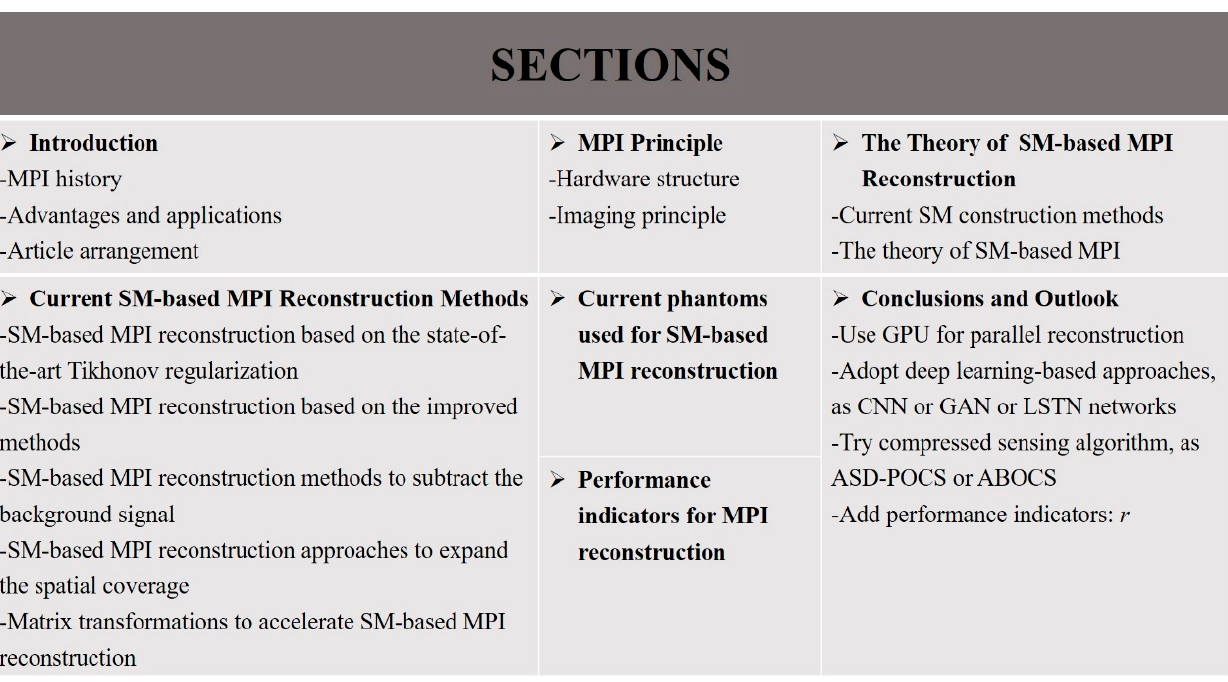
Figure 2. Organization of this work.